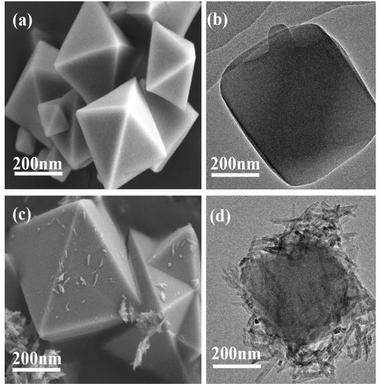
FESEM images of (a) UiO-66 and (b) Fe-UiO-66 and TEM (c) images of UiO-66 (d) Fe-UiO-66.